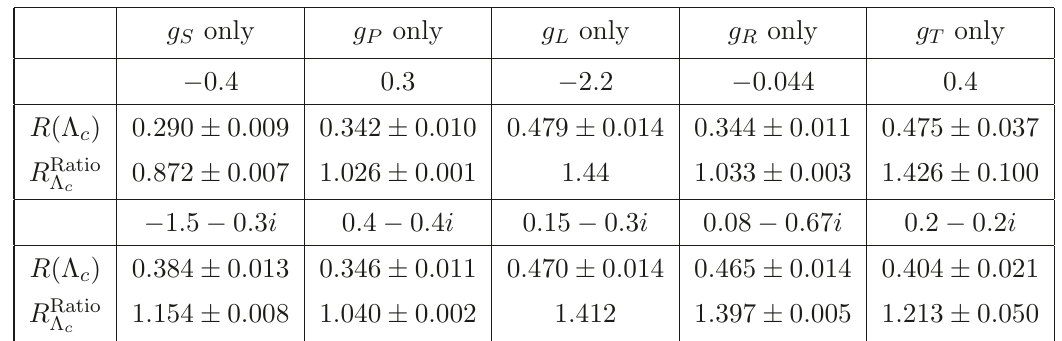
for two example choices (real-valued and complex- Λ c 0 . 010 [48]. The ±